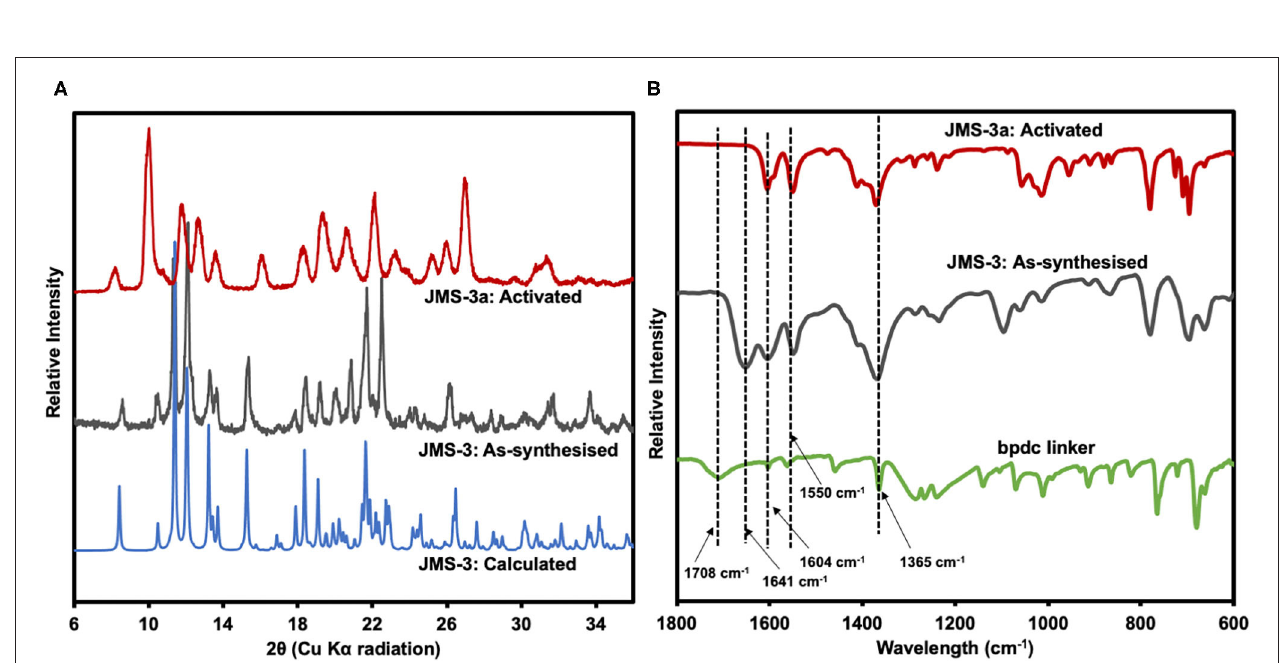
FIGURE 5 | (A) PXRD patterns of calculated, as-synthesized and activated JMS-3. (B) IR spectra of the linker, as synthesized and activated JMS-3.